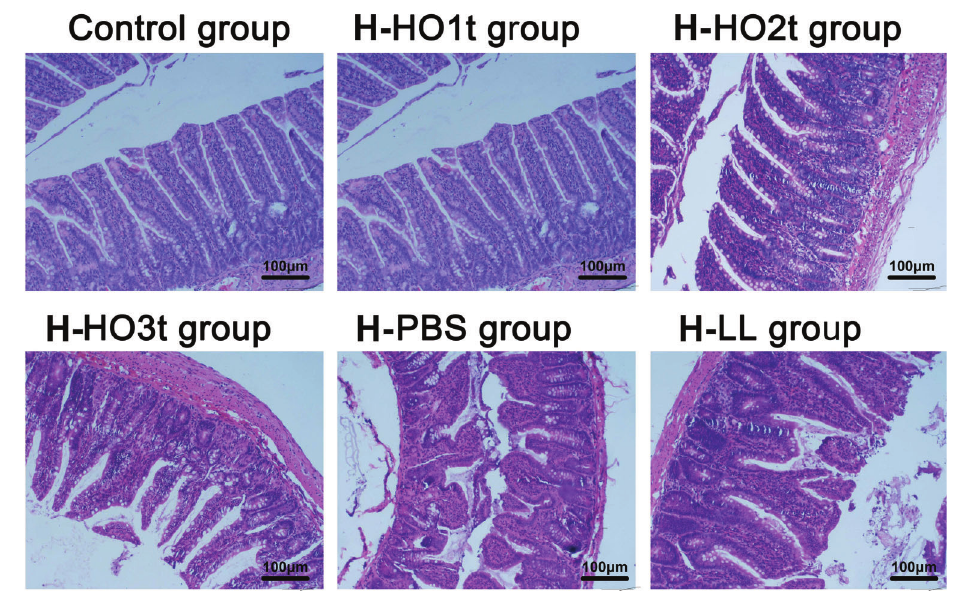
Figure 6. Pathological examination of intestinal tissue of hemorrhagic shock (H) groups treated with Lactococcus lactis expressing heme oxygenase-1 once (HO1t), twice (HO2t) or thrice (HO3t) or with phosphate-buffered saline (PBS) and L. lactis (LL). Control group refers to healthy rats (HE staining; (cid:1)